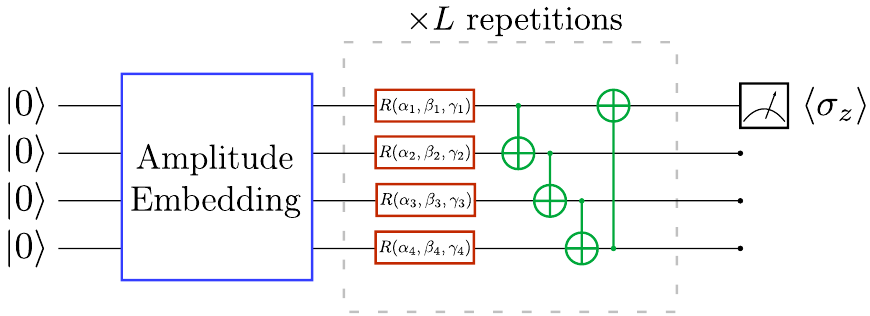
Figure 2. Circuit representation of the Amplitude Embedding model. In blue, variables are em- bedded into the amplitudes of a quantum state. In red, trainable generic rotational gates to be opti- mised during the training phase. In green, CNOT gates entangling qubits with a circular topology.